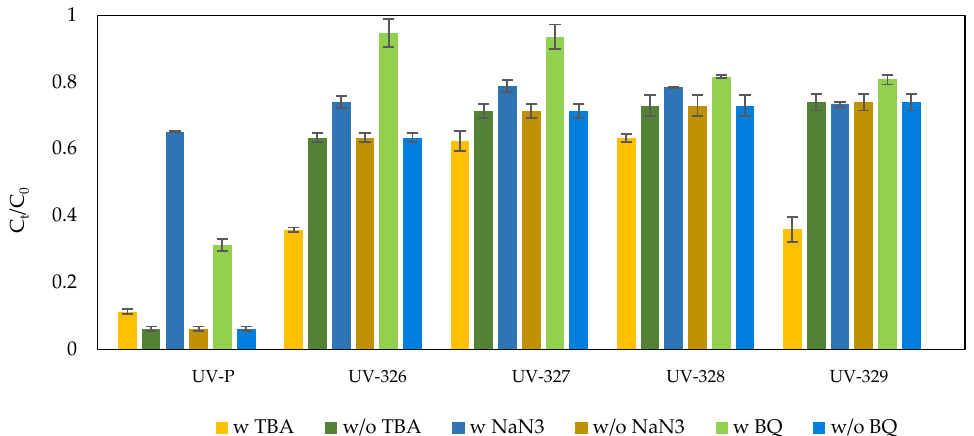
Figure 7. Effect of radical scavengers on UV stabilizers’ degradation in the Co 2+ /PAA process (w”—reaction with radical quencher, w/o”—reaction without radical quencher).